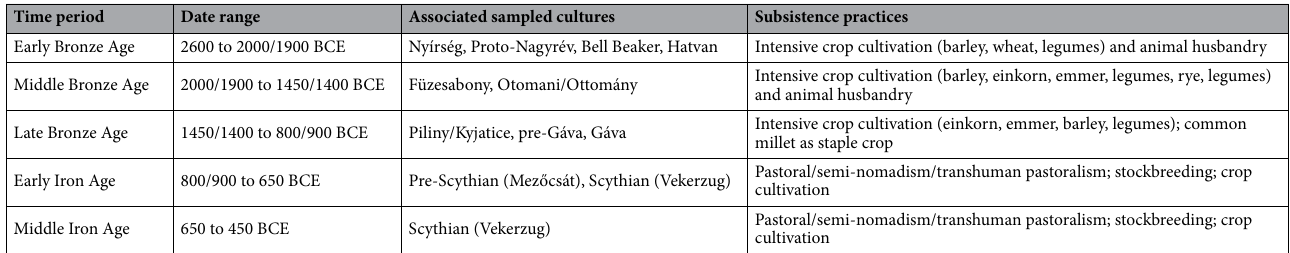
Table 1. Summary of the prehistoric time periods and their associated cultures and subsistence practices in the GHP. Adapted from Gamarra et al. 58